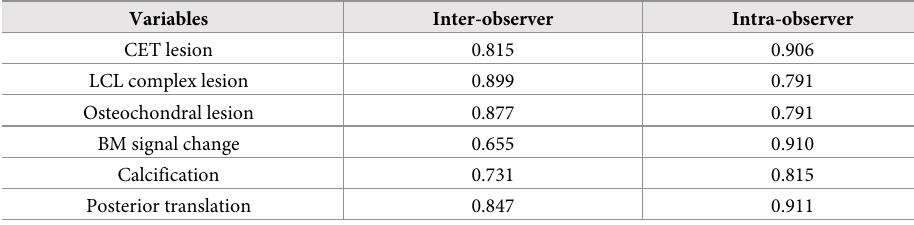
Table 1. Cohen’s kappa of inter- and intra-observer reliability.